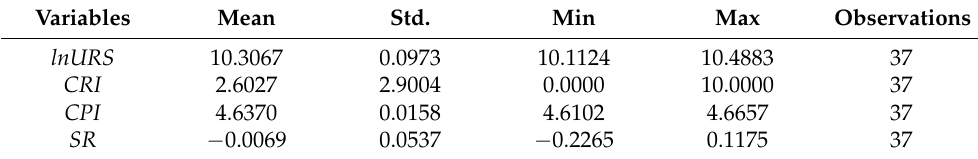
Table 1. Descriptive statistics of the variables. Variables Mean Std. Min Max Observations lnURS